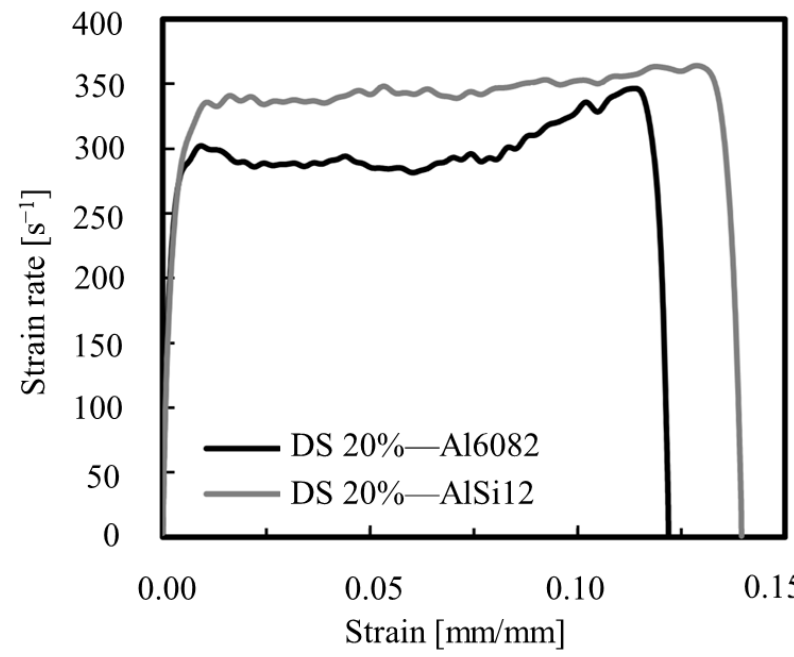
Figure 5. Strain rate – strain curves [25].